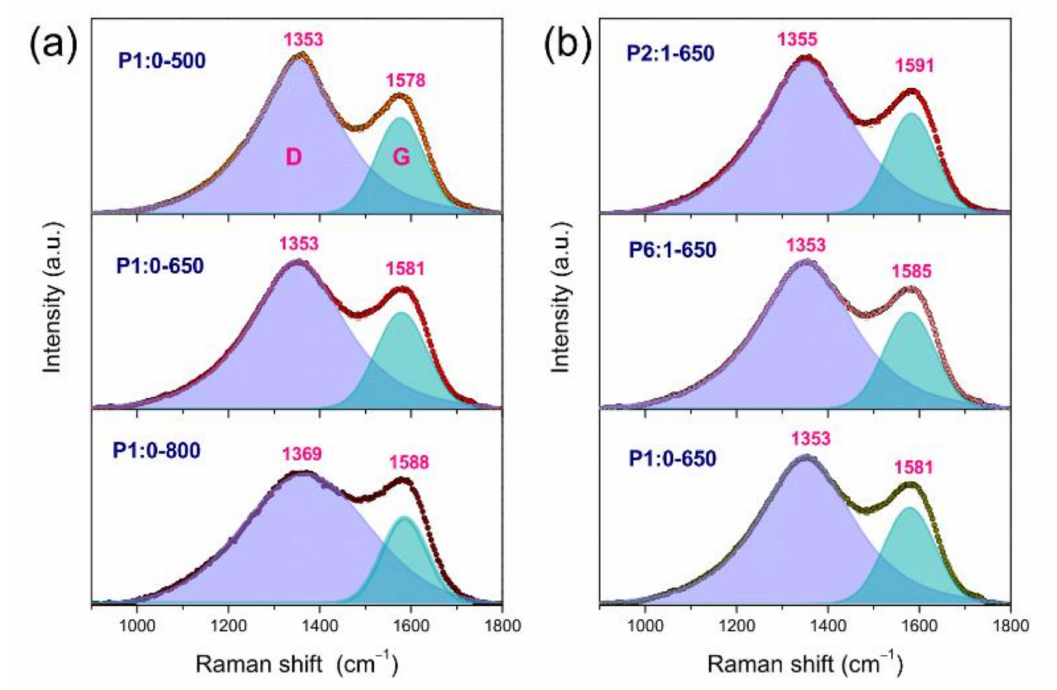
Figure 4. Micro-Raman spectra of ( a ) PAN-based membranes carbonised at different temperatures and ( b ) PAN/PMMA- derived membranes with different amount of PMMA carbonised at 650 ◦